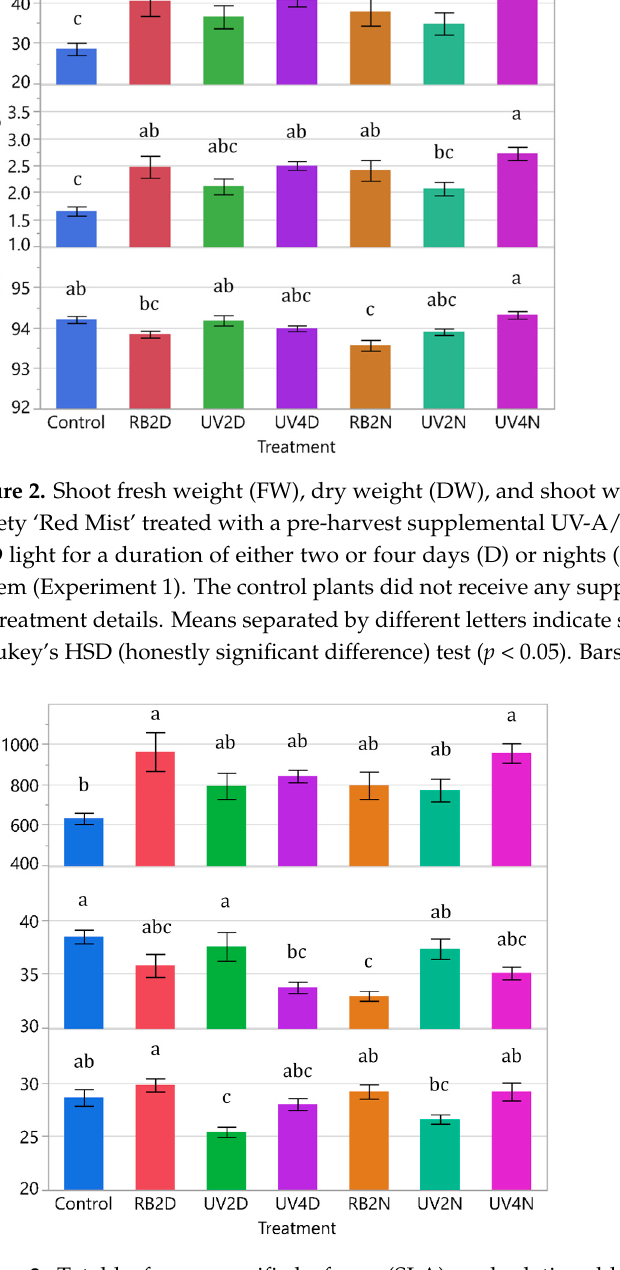
Figure 6. Total leaf area, specific leaf area (SLA), and relative chlorophyll content (SPAD), of the lettuce variety ‘Red Mist’ treated with pre-harvest supplemental UV-A/Blue (UV) or Red and Blue (RB) LED light for a duration of either two or four days (D) or nights (N), in a greenhouse hydro- ponic system (Experiment 2). The control plants did not receive any supplemental LED light. See Table 2 for treatment details. Means separated by different letters indicate significant differences according to Tukey’s HSD (honestly significant difference) test ( p < 0.05). Bars represent standard error.